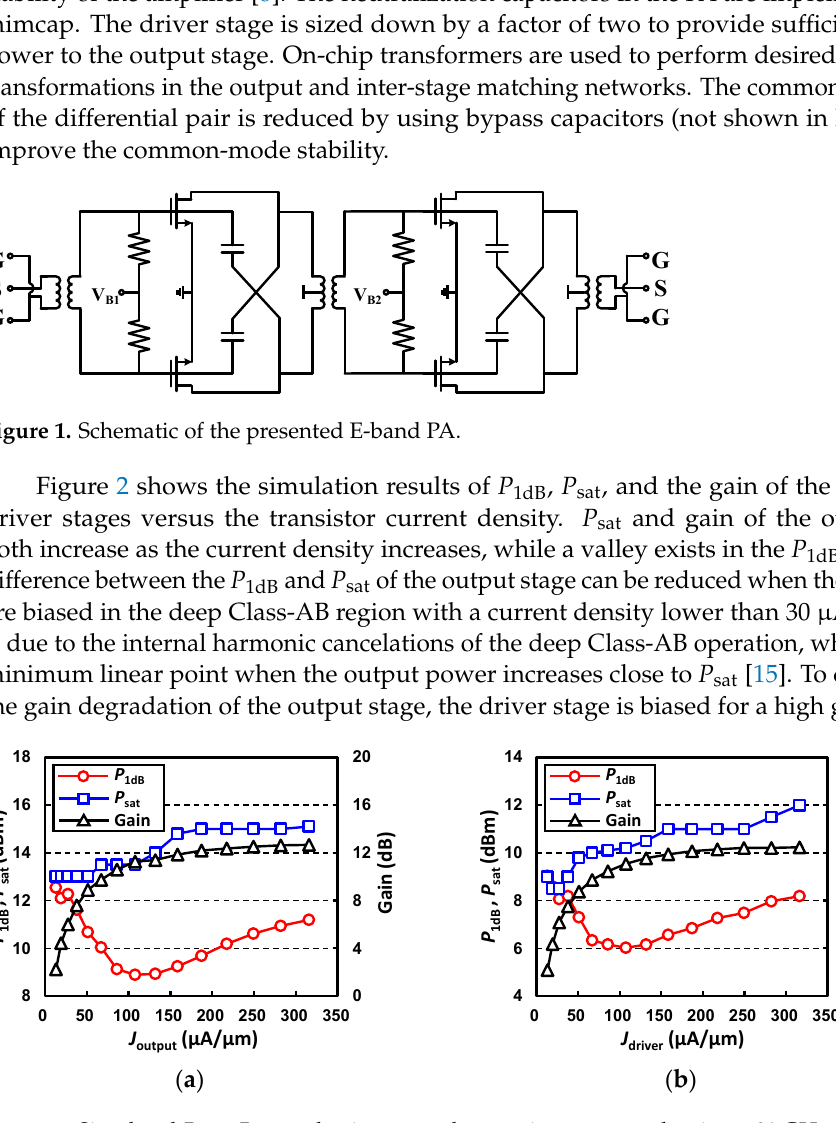
Figure 2. Simulated P 1dB , P sat , and gain versus the transistor current density at 81 GHz at 1 V supply: ( a ) output stage; ( b ) driver